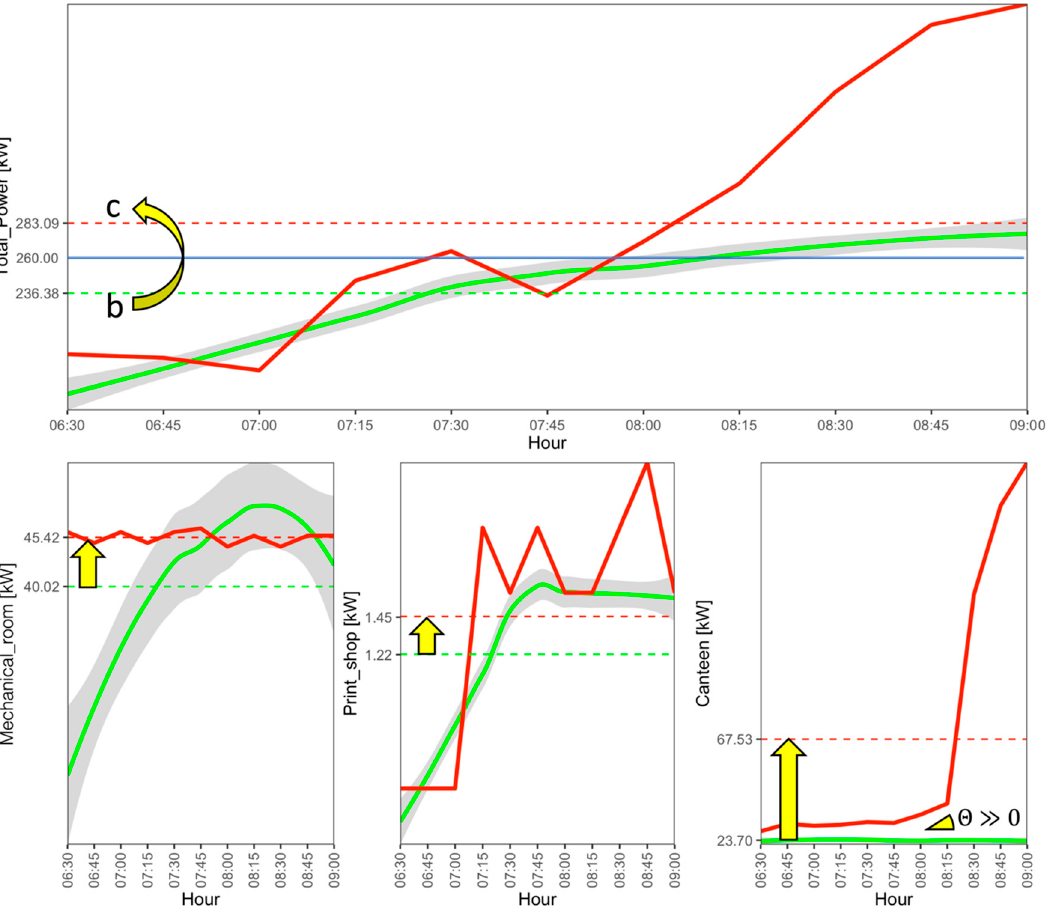
Figure 15. Comparison between the actual (red lines) and expected (green lines) electrical load with the relative standard deviation (grey areas) on 4 January 2019. The dashed green and red lines represent the PAA segments for the actual and expected load respectively. The blue horizontal solid line on the top graph represents the aSAX breakpoint related to the total